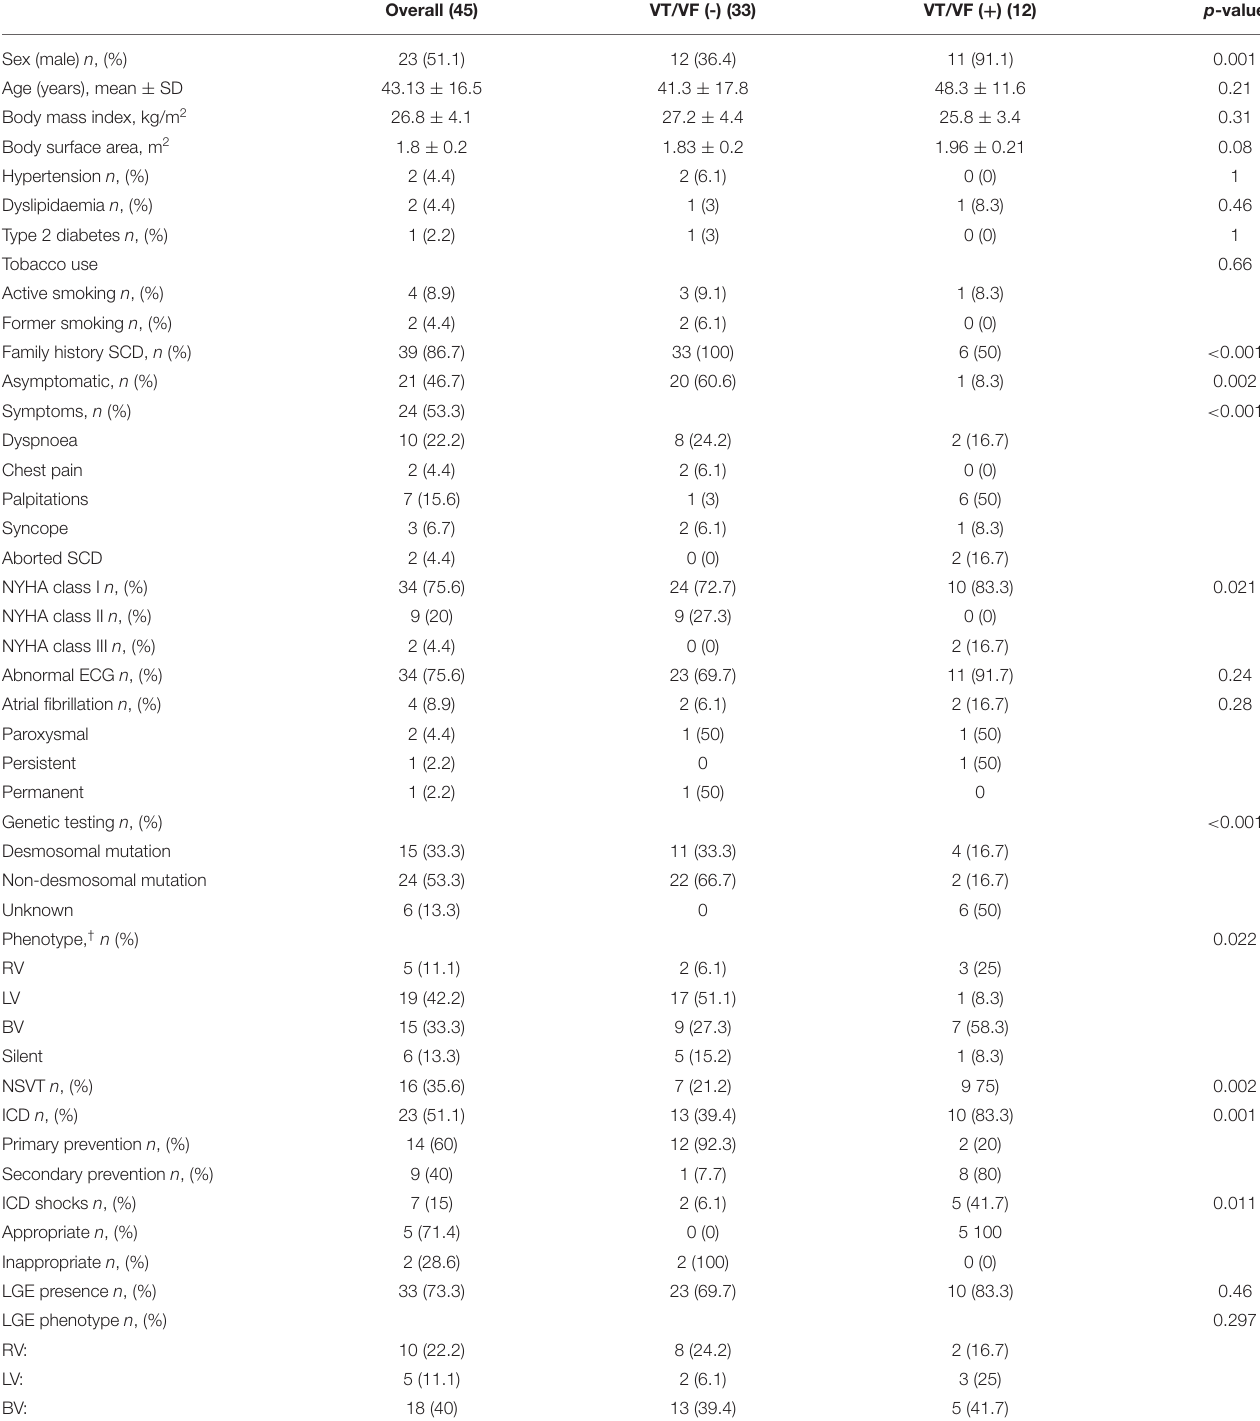
TABLE 1 | The baseline